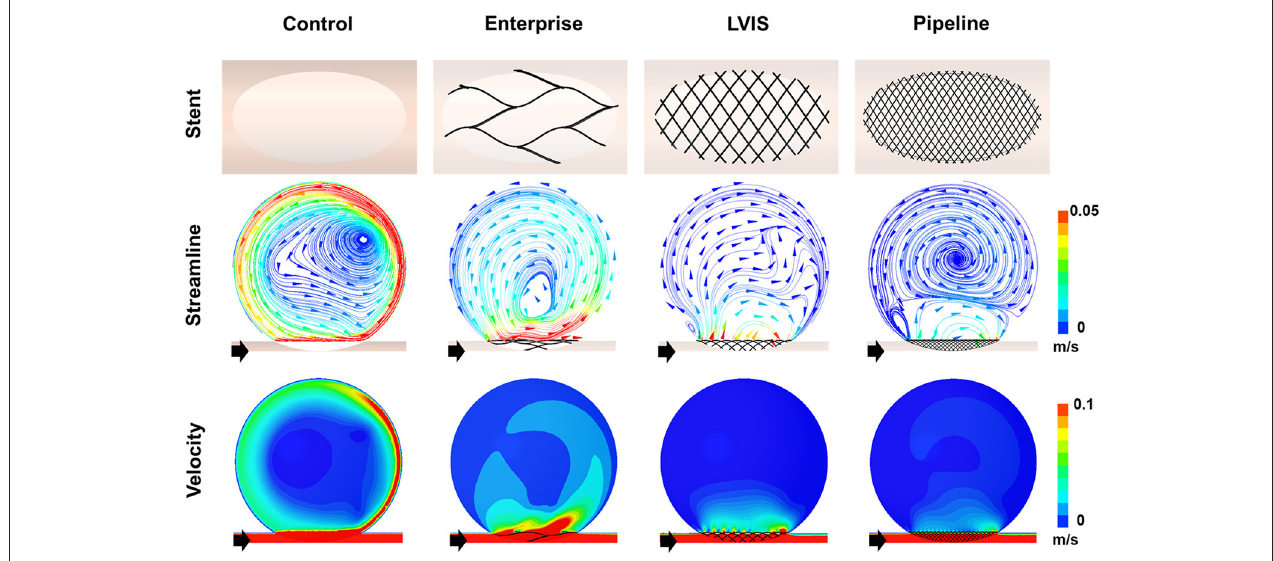
FIGURE 3 | Visualization of the hemodynamic modification of the idealized aneurysm model by each stent. The stent configurations in the idealized aneurysm model and the streamlines and velocity contours calculated using CFD analysis are displayed. The black arrows indicate the flow direction. With the Enterprise stents, the velocity magnitude of the jet flow was decreased compared with that of the control, but the flow pattern of inflow from the distal part of the aneurysmal neck and outflow to the proximal side did not change. In contrast, the LVIS and Pipeline devices disrupted and changed the direction of the inflow jet. Particularly with the Pipeline device, the jet flow was not transferred into the aneurysmal dome due to the remarkable reduction of inflow jet. This led to a silent vortex in the aneurysmal sac due to a separation in the hemodynamics of the aneurysmal dome and neck. CFD, computational fluid